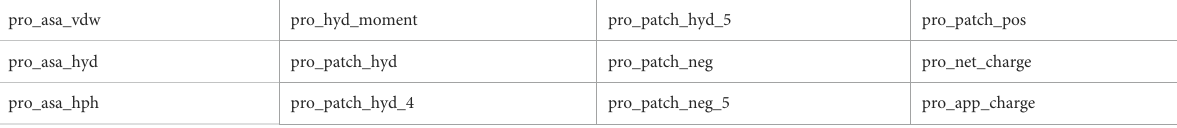
TABLE 8 12 features out of 51 were selected having a feature score of four using the feature scoring table for OPRD1.